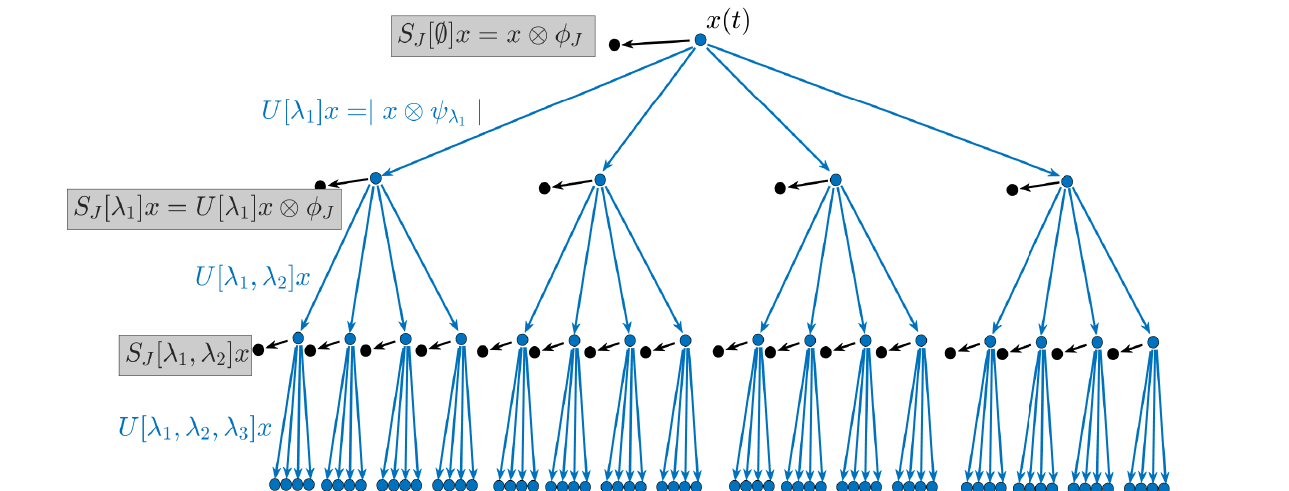
on 1 on the each previous result U [ λ 1 ] x . The 2